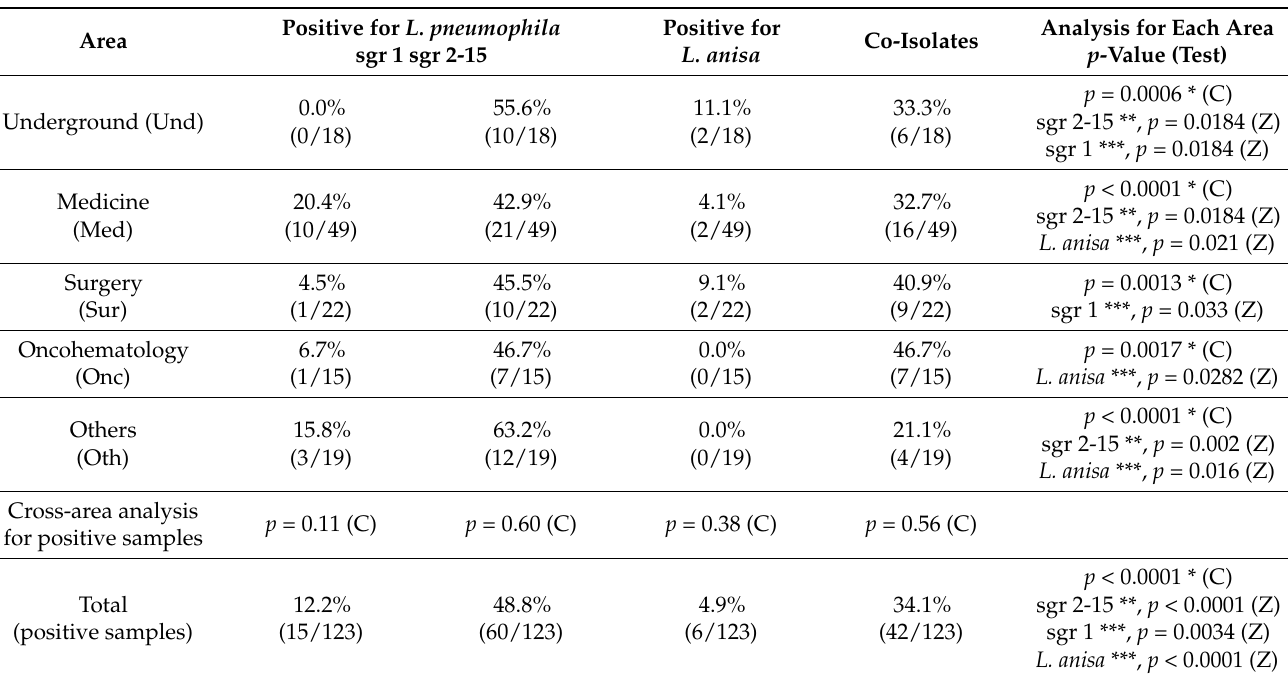
Table 2. Distribution of L. pneumophila sgr 1 and sgr 2-15, of L. anisa and isolates in the five